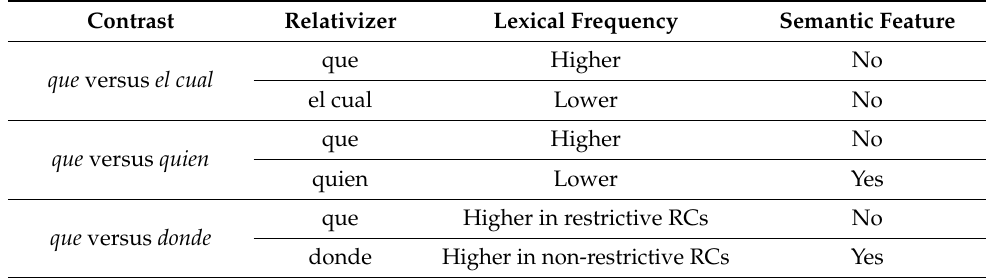
Table 3. Linguistic features of Spanish relativizers according to our corpus study. Contrast Relativizer Lexical Frequency Semantic